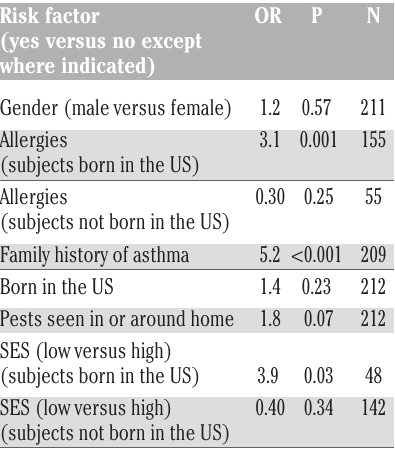
Table 3. Risk factors for asthma